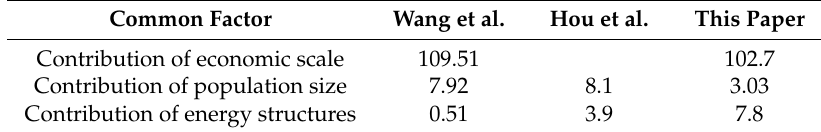
Table 6. Contributions of each common factor shaping carbon emissions by the power industry. Unit: %. Common